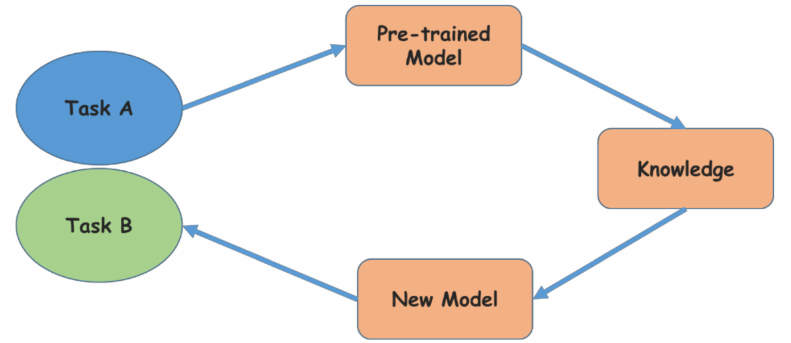
Figure 7. Illustration of the main idea of transfer learning technique.